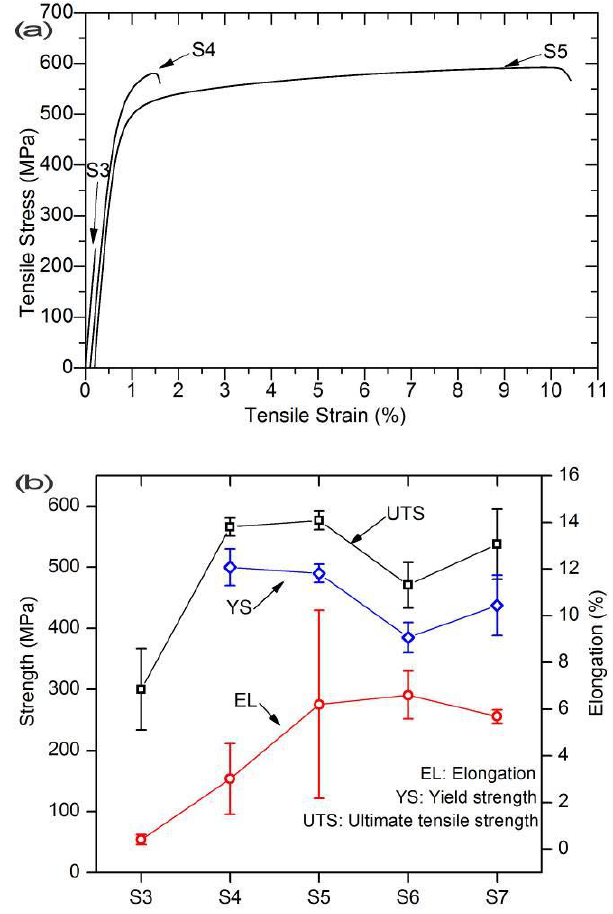
Table 1. Sintered density in terms of percentage of theoretical density for slices taken from the large cylinder.